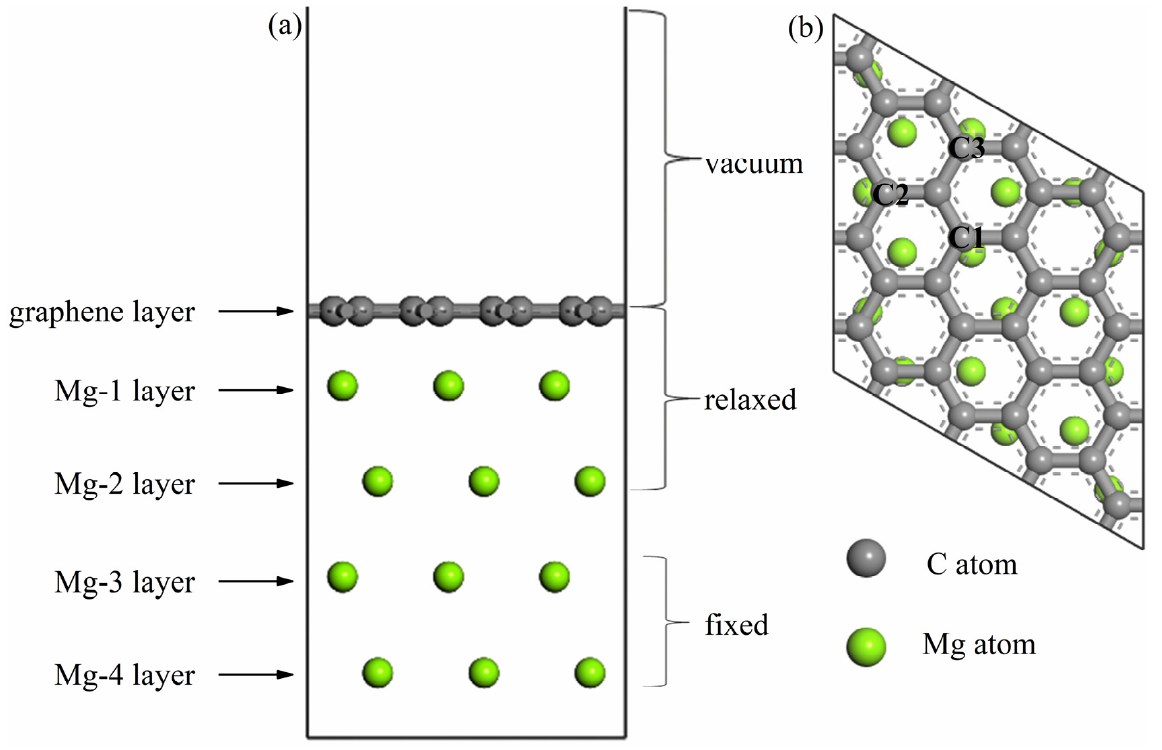
Figure 6. The intrinsic interface model: ( a ) side view; ( b ) top view (the position of the C atom sur- rounded by C1, C2, and C3 is the position of the doped atom).